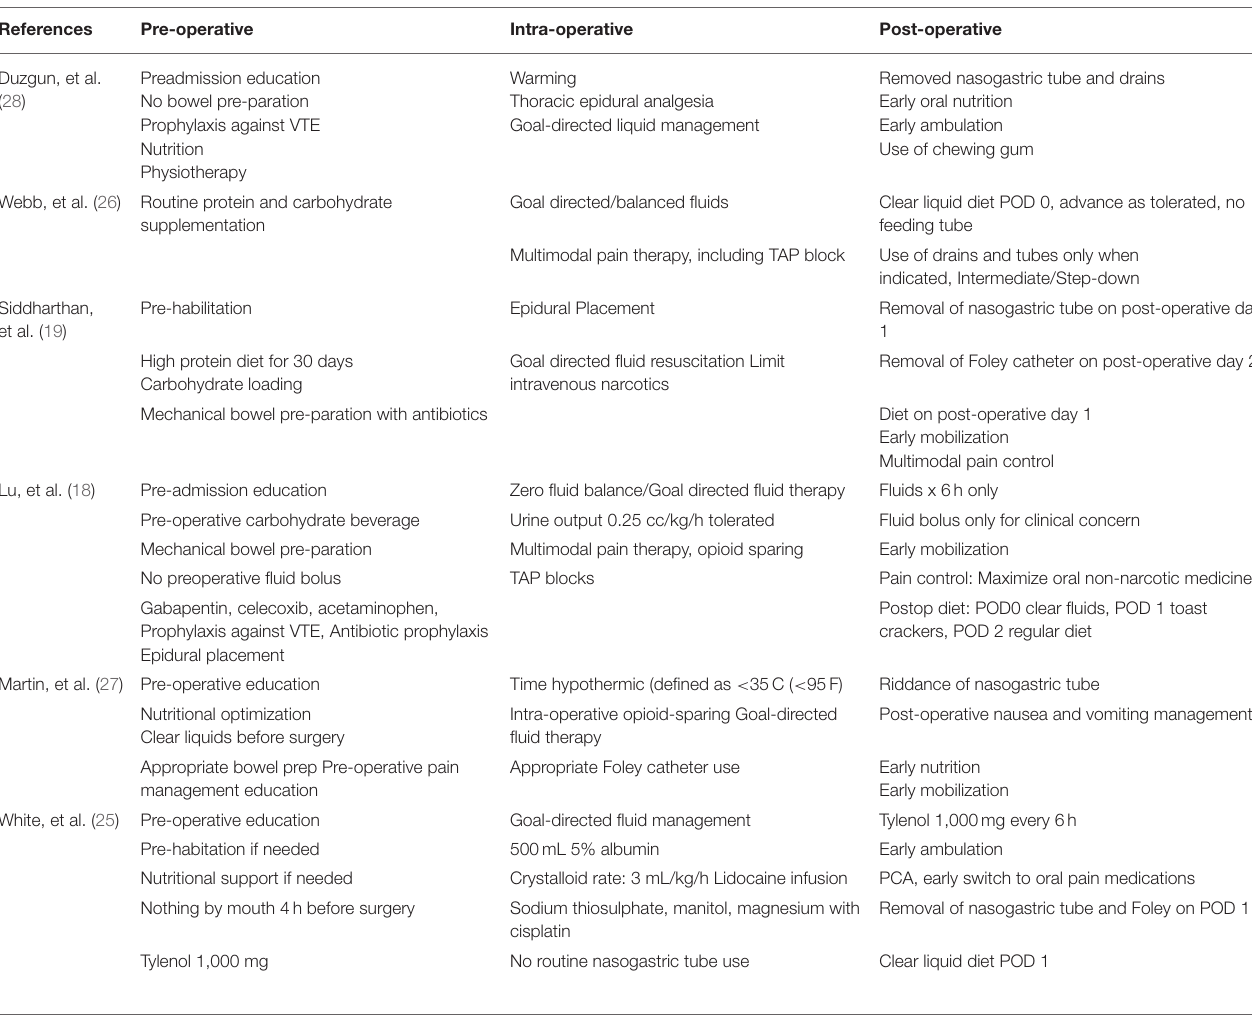
TABLE 2 | ERAS elements in the included studies.